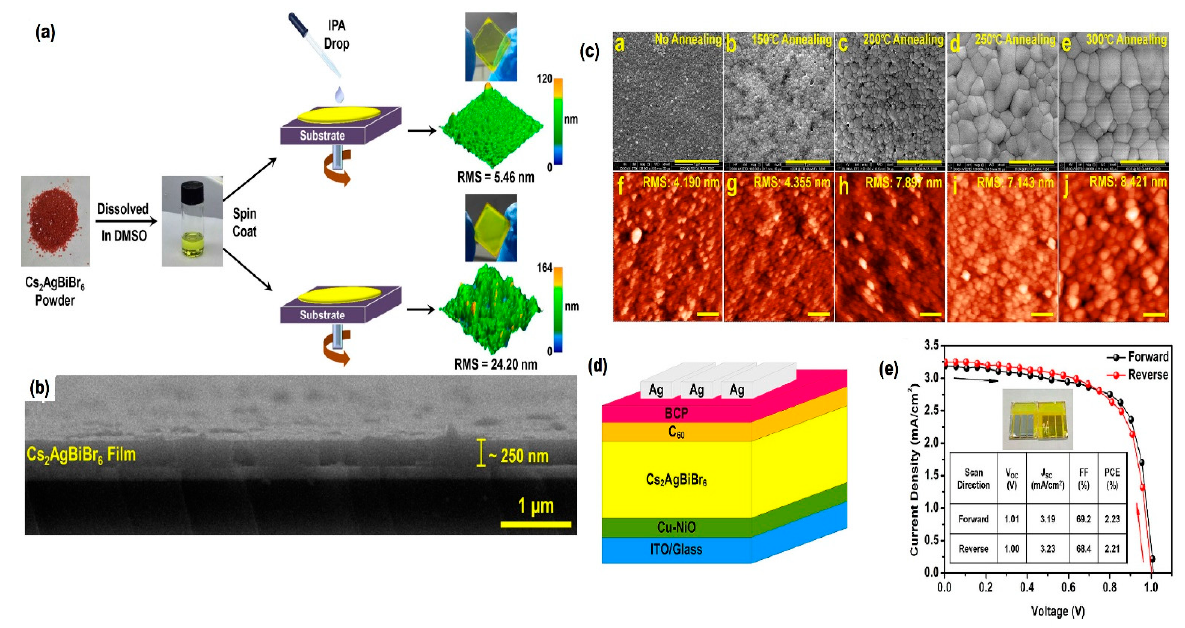
Figure 11. ( a ) Schematic illustration of the spin-coating process (with and without anti-solvent dropping protocol); ( b ) Cross-sectional SEM image of a Cs 2 AgBiBr 6 film obtained by IPA dipping; ( c ) SEM images and AFM images of Cs 2 AgBiBr 6 films annealed at different temperatures; ( d ) Structure of the inverted PSC devices fabricated in this work and; ( e ) J-V curves of the best-performing device based on Cs 2 AgBiBr 6 films obtained at different fabrication conditions. Reproduced with permission from [81] . Copyright 2018, Wiley-VCH.